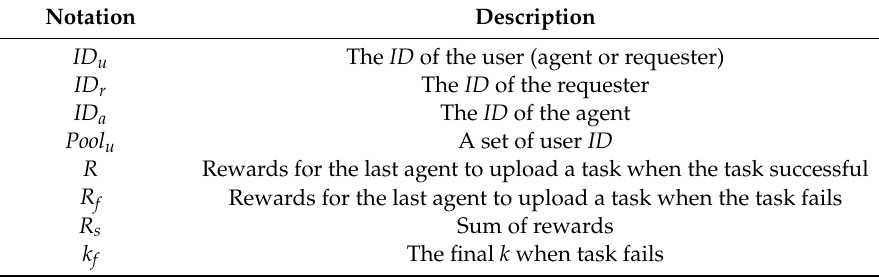
Table 1. Notations.